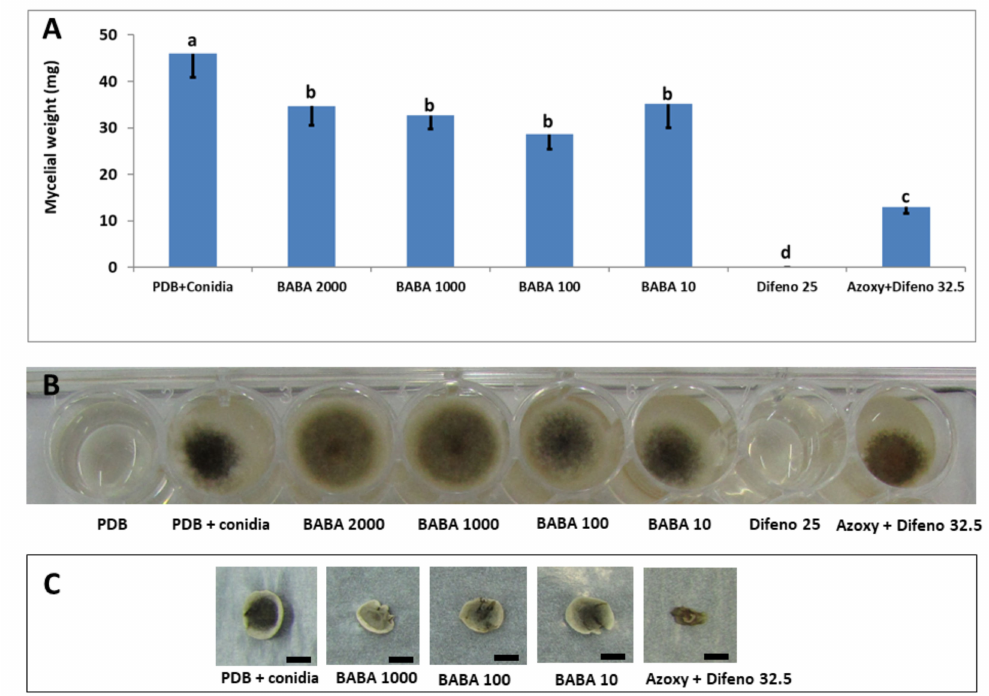
Figure 2. ( A ) Activity of BABA, difenoconazole (Difeno) and pre-mixture azoxystrobin plus difeno- conazole (Azoxy + Difeno) on growth of A. alternata f. sp. mali in liquid medium. Concentrations are given in µ g/mL of active ingredient. Bars represent the standard error of the mean. Different letters on columns indicate significant differences ( p < 0.05) between treatments (Fisher’s LSD K-ratio t -test). ( B ) Representative wells of various treatments at seven days post inoculation. ( C ) Representative mycelial mats from each treatment on a blotting paper. Bar = 10